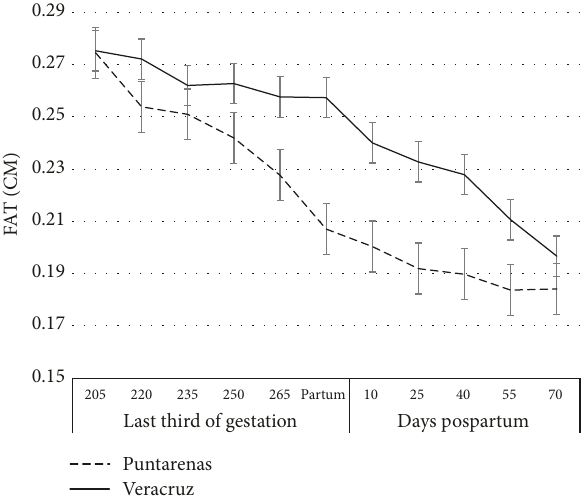
Figure 2: Daylight/hours in Veracruz and Puntarenas from January to August 2015. Fat thickness (FAT).